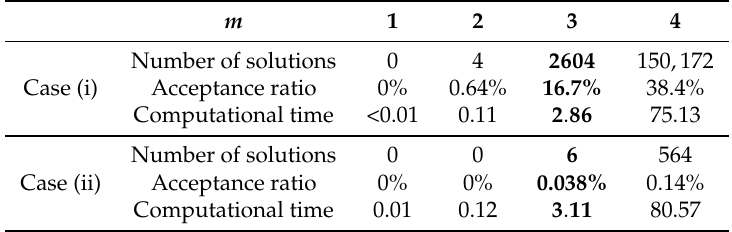
Table 1. Network reconstruction results for Case (i) and Case (ii), for different hypotheses on the number of reactions m . Number of solutions refers to the number of different stoichiometry matrices in Ω . Acceptance ratio is the number of solutions divided by the number of stoichiometry matrices tested, given by | S | = 5 2 m . Computational times are in seconds, evaluated on a 4-core 3GHz Intel Xeon processor (Santa Clara, CA, USA). Results for the true number of reactions ( m = m ∗ ) are reported in bold.